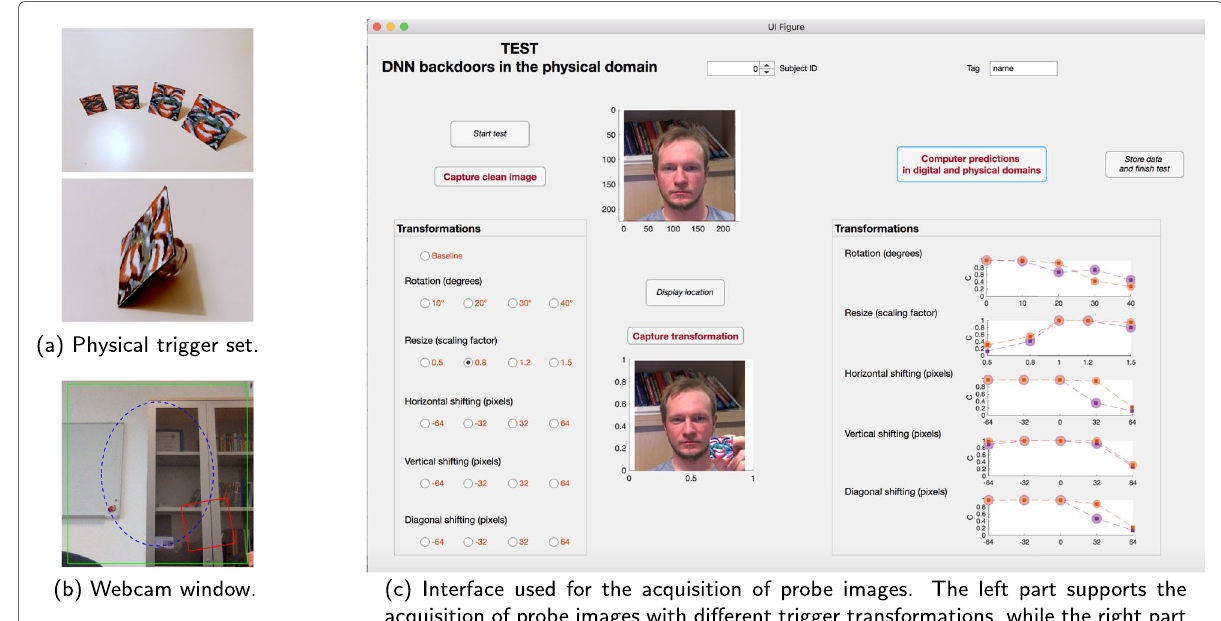
Fig. 8 Implementation of the validation experiments in the physical